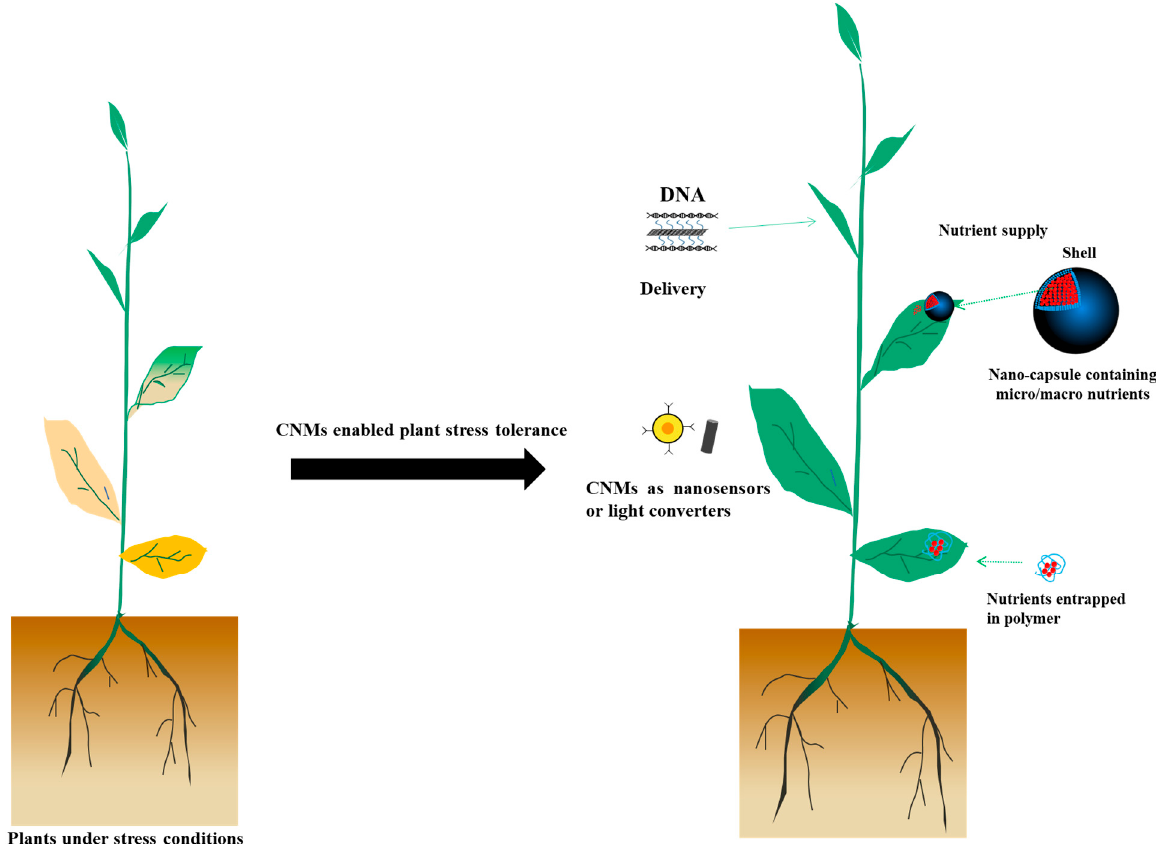
Figure 1. The role of CNMs in nanosensors, agrochemical delivery, and light converters in agricul-